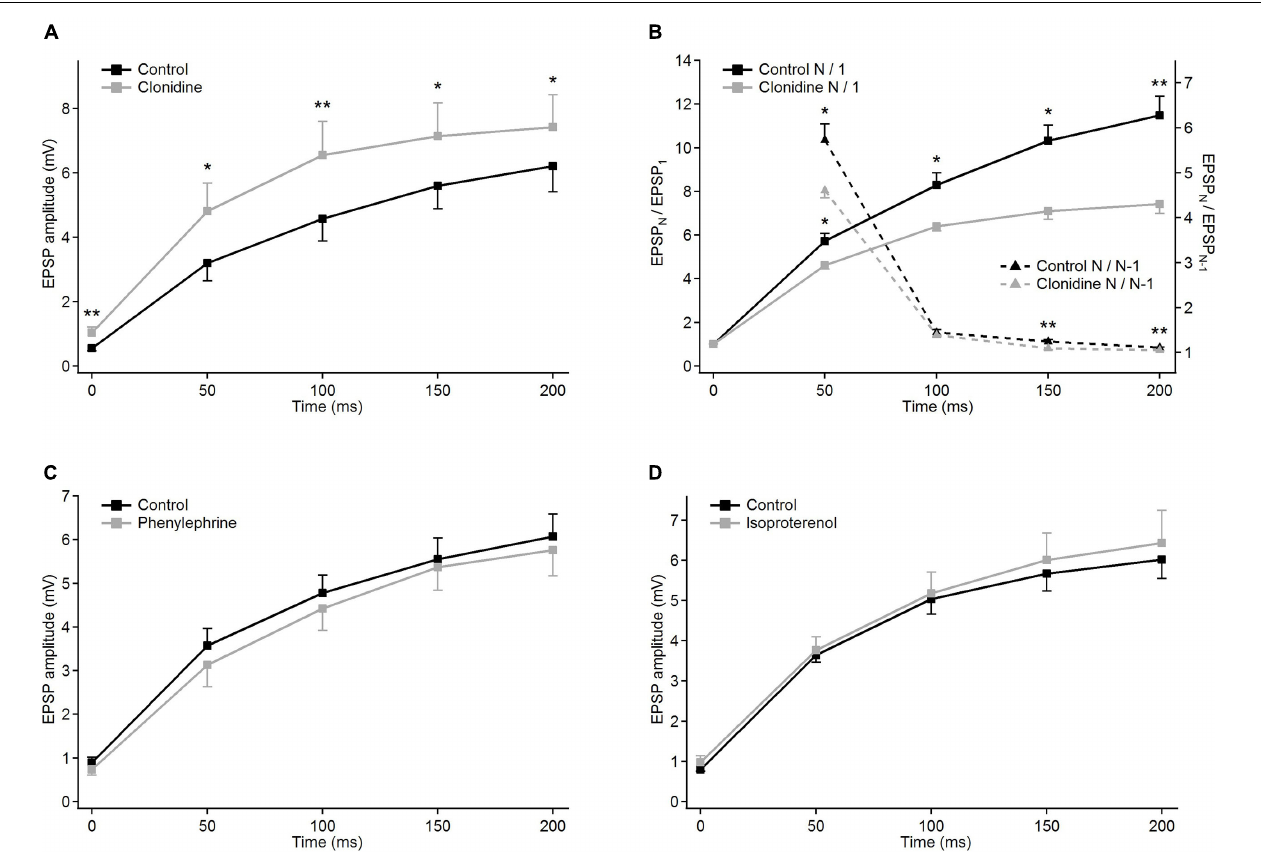
FIGURE 6 | Modulatory effects of different noradrenergic agents on EPSP trains in PoM cells. Group average of EPSP amplitudes in the control condition (black traces) and after application of the drugs (gray traces): (A) 40 µ M clonidine ( n = 6); (C) 100 µ M phenylephrine ( n = 6) and (D) 100 µ M isoproterenol ( n = 7). (B) Clonidine effects on normalized EPSP amplitudes and momentary facilitation. Left Y axis: average normalized amplitudes (EPSP N /EPSP 1 ) in the control condition (solid black trace) and in the presence of clonidine (solid gray line). Right Y axis: average ratios of the consecutive EPSP amplitudes (EPSP N /EPSP N − 1 ) in the control condition and after application of clonidine (black and gray dashed lines, respectively). For all NE drugs, control bath solution contained GABA inhibitors plus sodium ascorbate. Data are expressed as mean ± SEM, * P ≤ 0.05 and ** P ≤ 0.01.